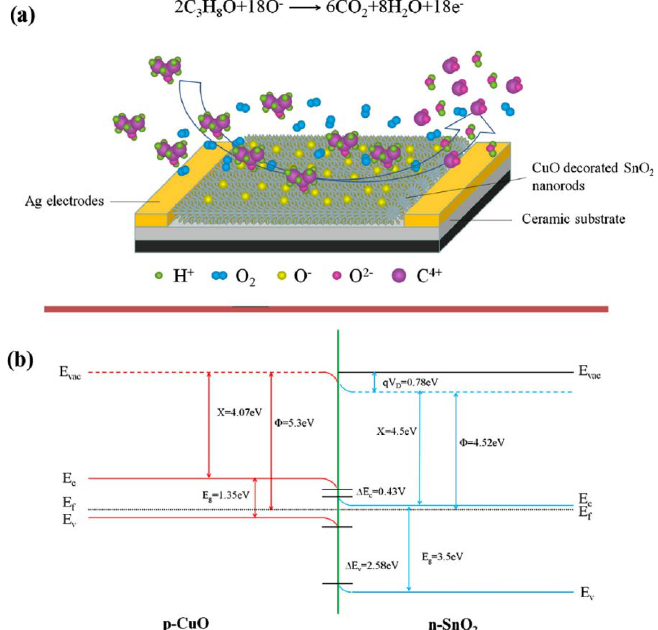
Figure 6. ( a ) Schematic view of the possible sensing mechanism of sensors based on CuO-decorated SnO 2 NRs and ( b ) the proposed energy band structure diagram of the p-CuO/n-SnO 2 heterojunction. Reprinted with permission from [47]. Copyright 2018 Elsevier.